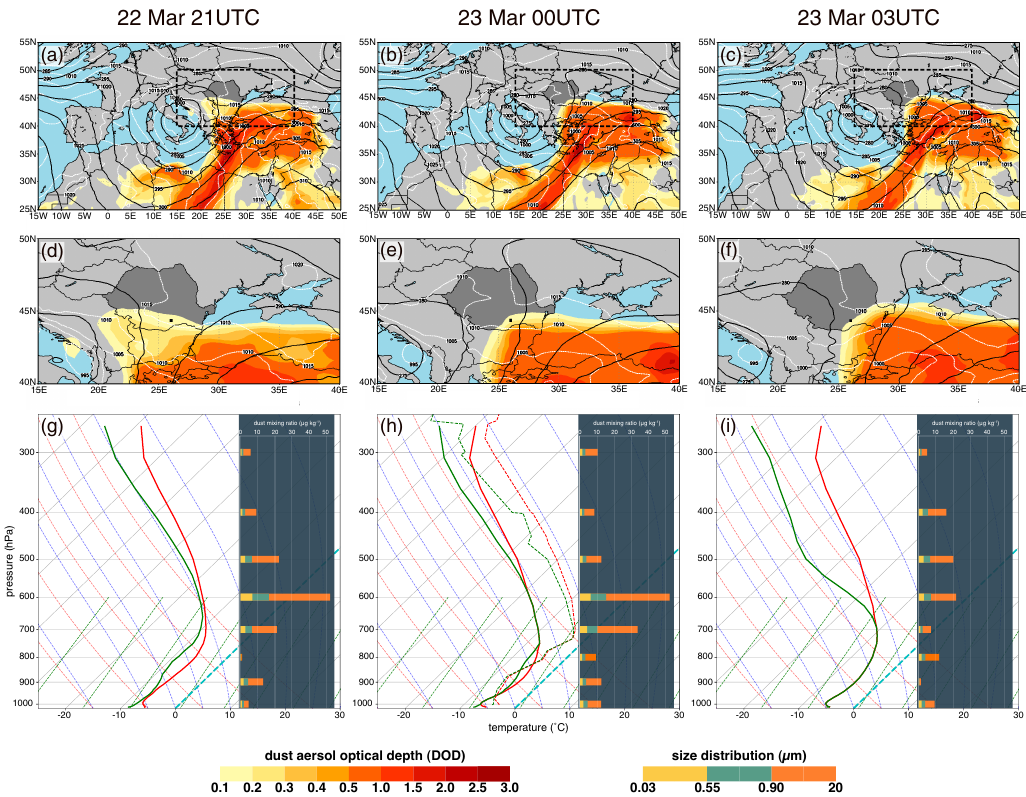
Figure 5. The synoptic analysis based on ECMWF data for ( a ) 22 March 2100 UTC; ( b ) 23 March 0000 UTC; and ( c ) 23 March 0300 UTC showing the surface pressure (white contours, every 5 hPa), the 500 hPa geopotential (black contours, every 5 gdam) and the dust aerosol optical depth retrieved from CAMS (shaded according to the scale on the bottom left). The regional scale analysis is shown in ( d – f ) for the area indicate by a dashed rectangle in ( a – c ) and for the same time steps. Also, for the same time steps as in ( a – c ), the hourly averaged vertical profiles of temperature and dew point temperature from RPG-HATPRO microwave radiometer are shown on Skew-T/log-P diagrams (red curve for temperature and green curve for dew point temperature) in ( g – i ). For each pressure level on the Skew-T/log-P diagrams, the dust mixing ratio provided by CAMS forecast are displayed in ( g – i ) (shaded according to the scale in the bottom right). Red and green dotted curves in ( h ) represents the profiles from the Bucharest–B˘aneasa sounding at 0000